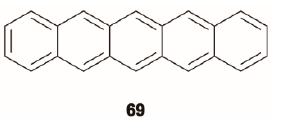
Scheme 23. Chemical structure of compound 69 .